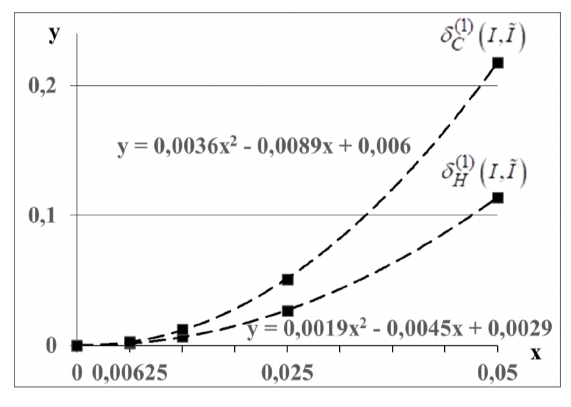
( I ) , - - - graphs of ( I ) , δ (1) C H